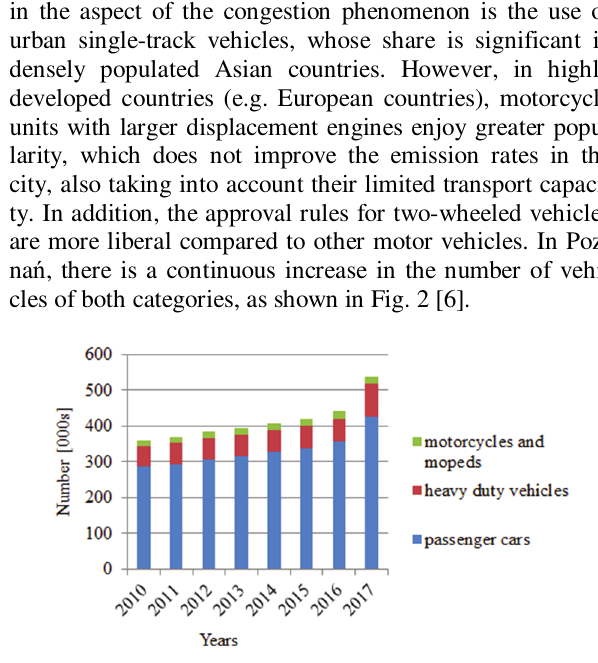
Fig. 2. Vehicles registered in Pozna ń by type and year